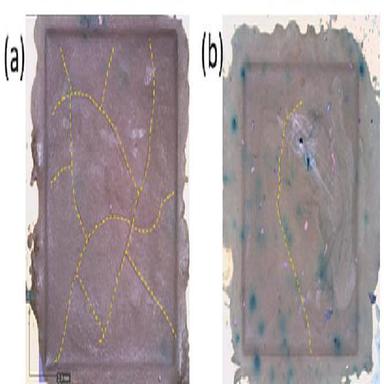
Optical microscopy of DIP encapsulated with (a) 35 wt% h-BN 750 rpm PN; (b) 30 wt% h-BN 20 wt% SiO2 750 rpm. Yellow dotted lines outline the hairline cracks observed under optical microscopy.